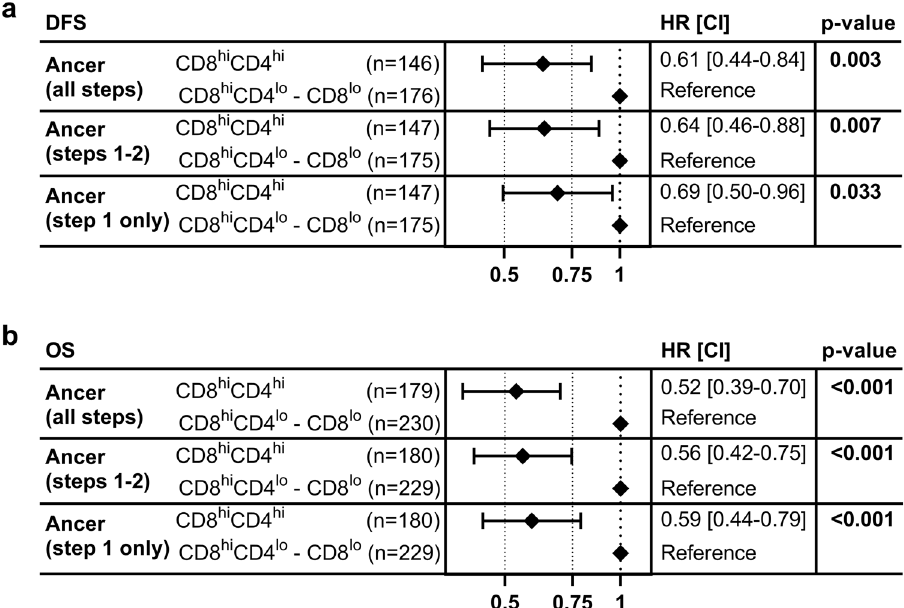
Figure 5. Effect of Ancer’s neoepitope and homology filters on survival analyses. Ancer neoepitope and homology filters improve association with disease free survival (DFS) ( a ) and overall survival (OS) ( b ). Hazard ratios (HR), confidence intervals (CI) and p -values ( p ) were calculated using univariate Cox proportional- hazard models. BCLA patients were separated based on their Ancer neoepitope burden (Ancer, all steps), similarly to Fig. 3, "non-matching" Ancer neoepitope burden without considering the JanusMatrix filter (Ancer, steps 1–2), or based on their "raw" Ancer neoepitope burden (Ancer, step 1 only).